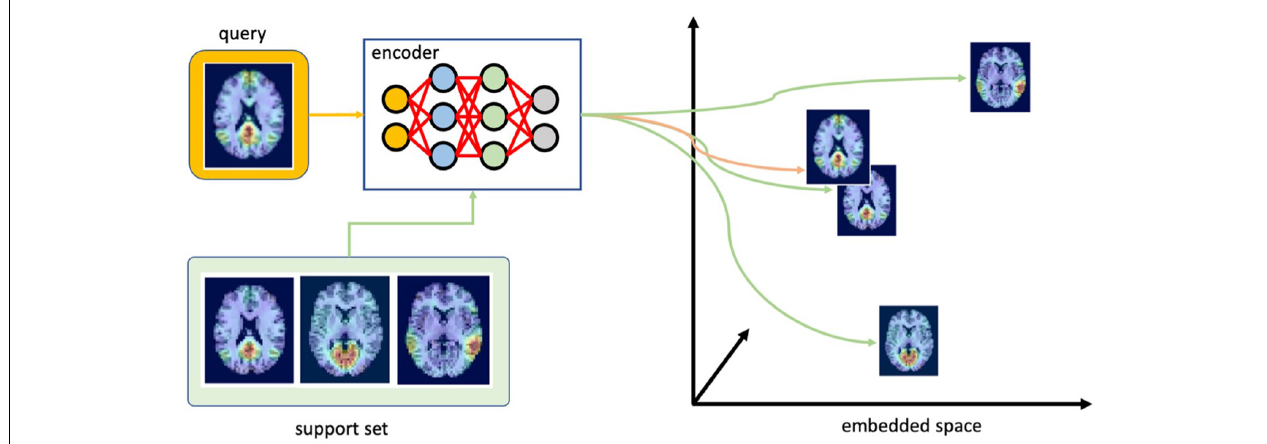
FIGURE 4 | Finding the most likely class for the test image (query). First, the encoder embeds the query using the embedding function learned during training. Next, it compares this embedding with the support set to select the most likely class for the query (ICA components were overlaid with TT-N27 template for illustration purposes in this figure; the template is not incorporated into the data submitted to the CNN during training or inference).